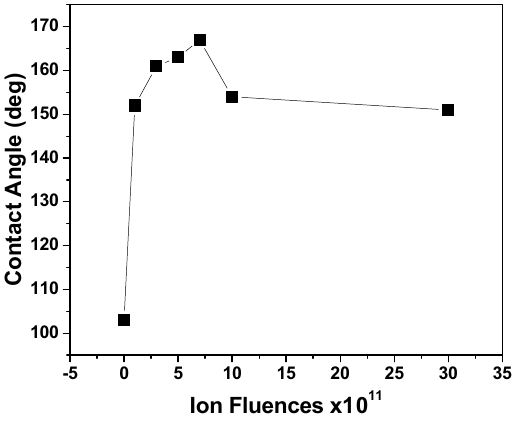
Figure 2. Wettability of the ZnO NR arrays irradiated under different fluences of 0, 1E11, 3E11, 5E11, 7E11, 1E12, 3E12 ions cm − 2 with 150MeV Ag 11 +